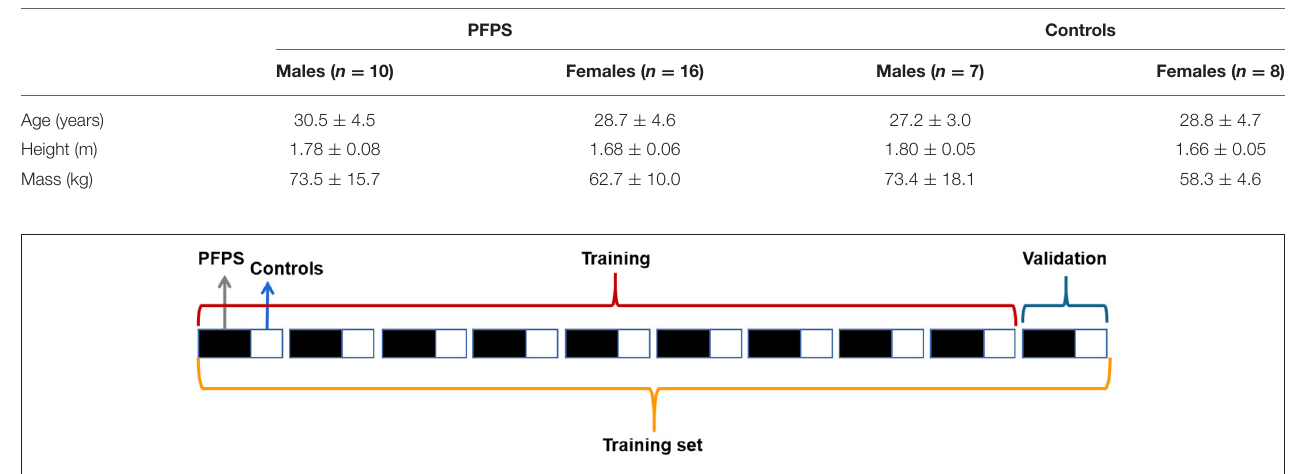
TABLE 1 | Mean ± SD age, height, and body mass of subjects.